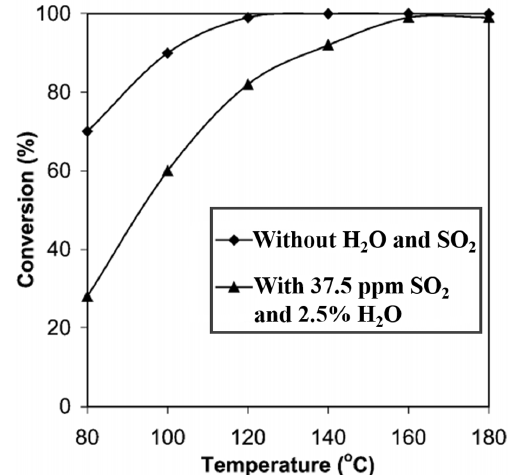
Figure 7. SCR activities on the Fe–Mn ‐ based transition metal oxides in the presence of SO 2 + H 2 O